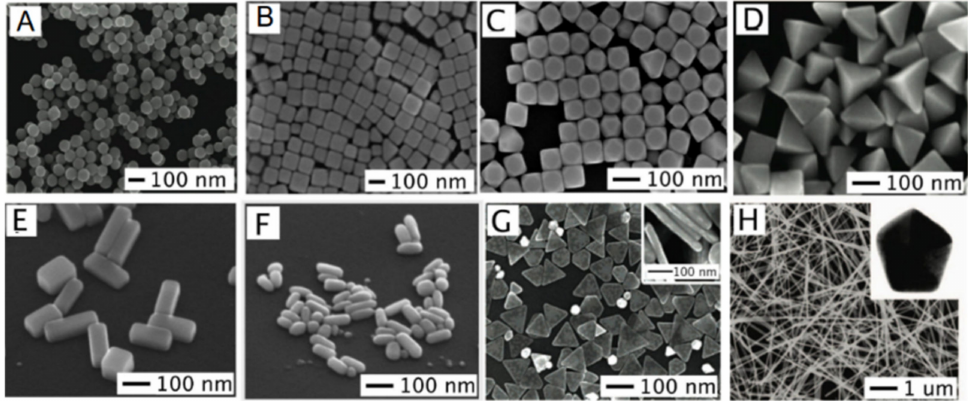
Figure 3. Typical nanoparticle geometries: ( A ) Spheres, ( B ) cubes, ( C ) truncated cubes, ( D ) right nanobipyramids, ( E ) bars, ( F ) spheroids, ( G ) triangular plates, ( H ) and wires. Reproduced with permission from [112].